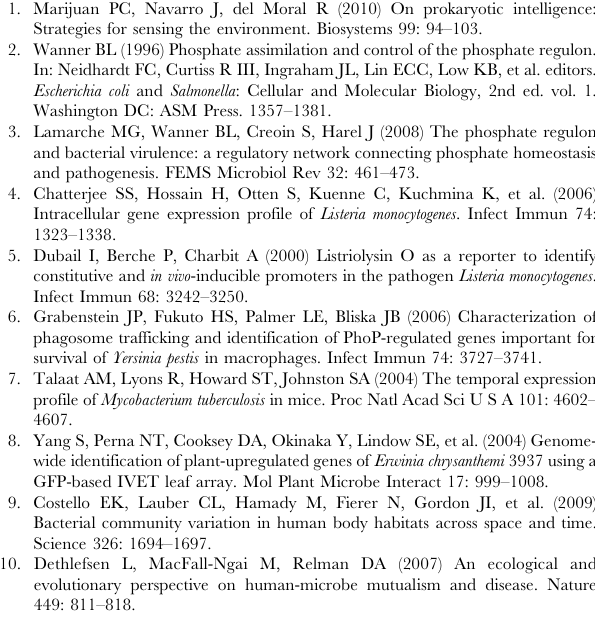
Table S1 PCR primers used in this study. Table S2 Two-component signal transduction systems